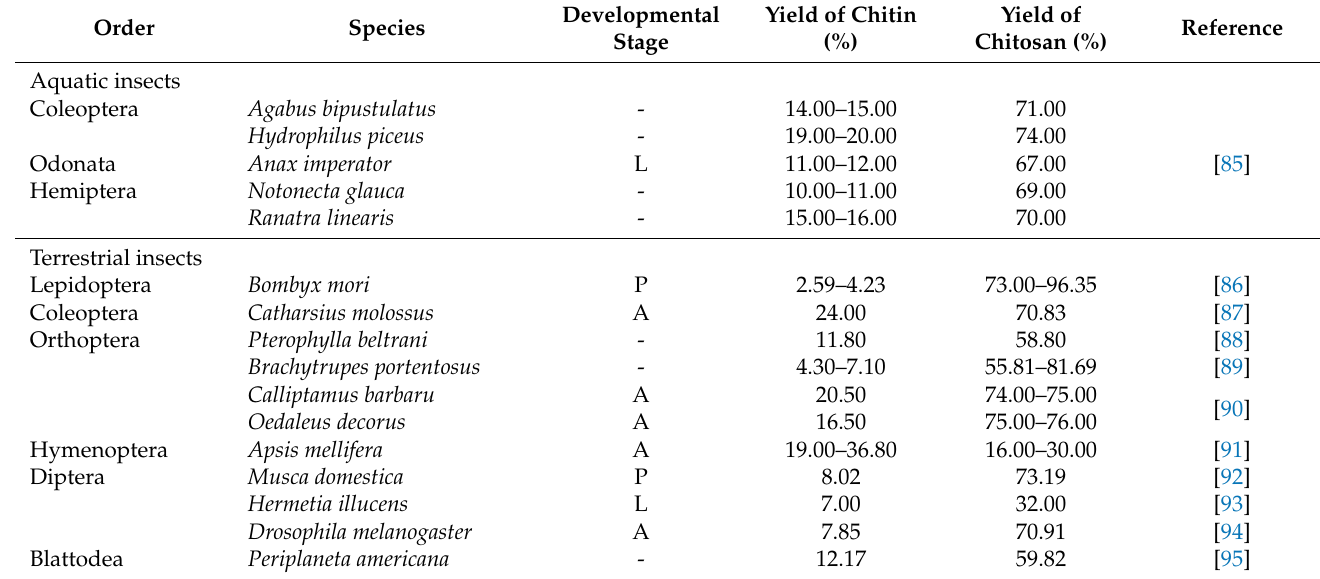
Table 5. Chitin and chitosan from aquatic insect and selected edible terrestrial